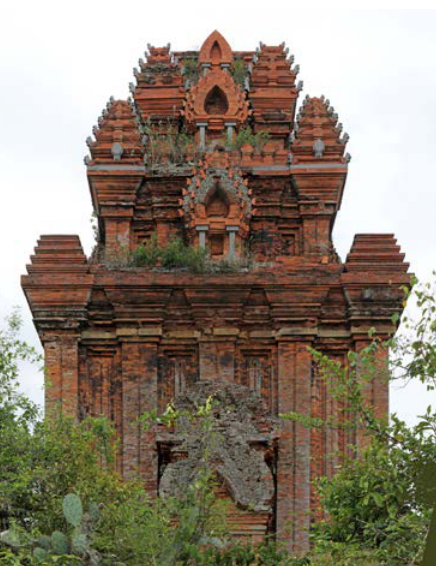
Figure 4. Banh it tower. Its peak looks like a Banh It (three- cornered glutinous rice cake filled with green bean paste and meat).